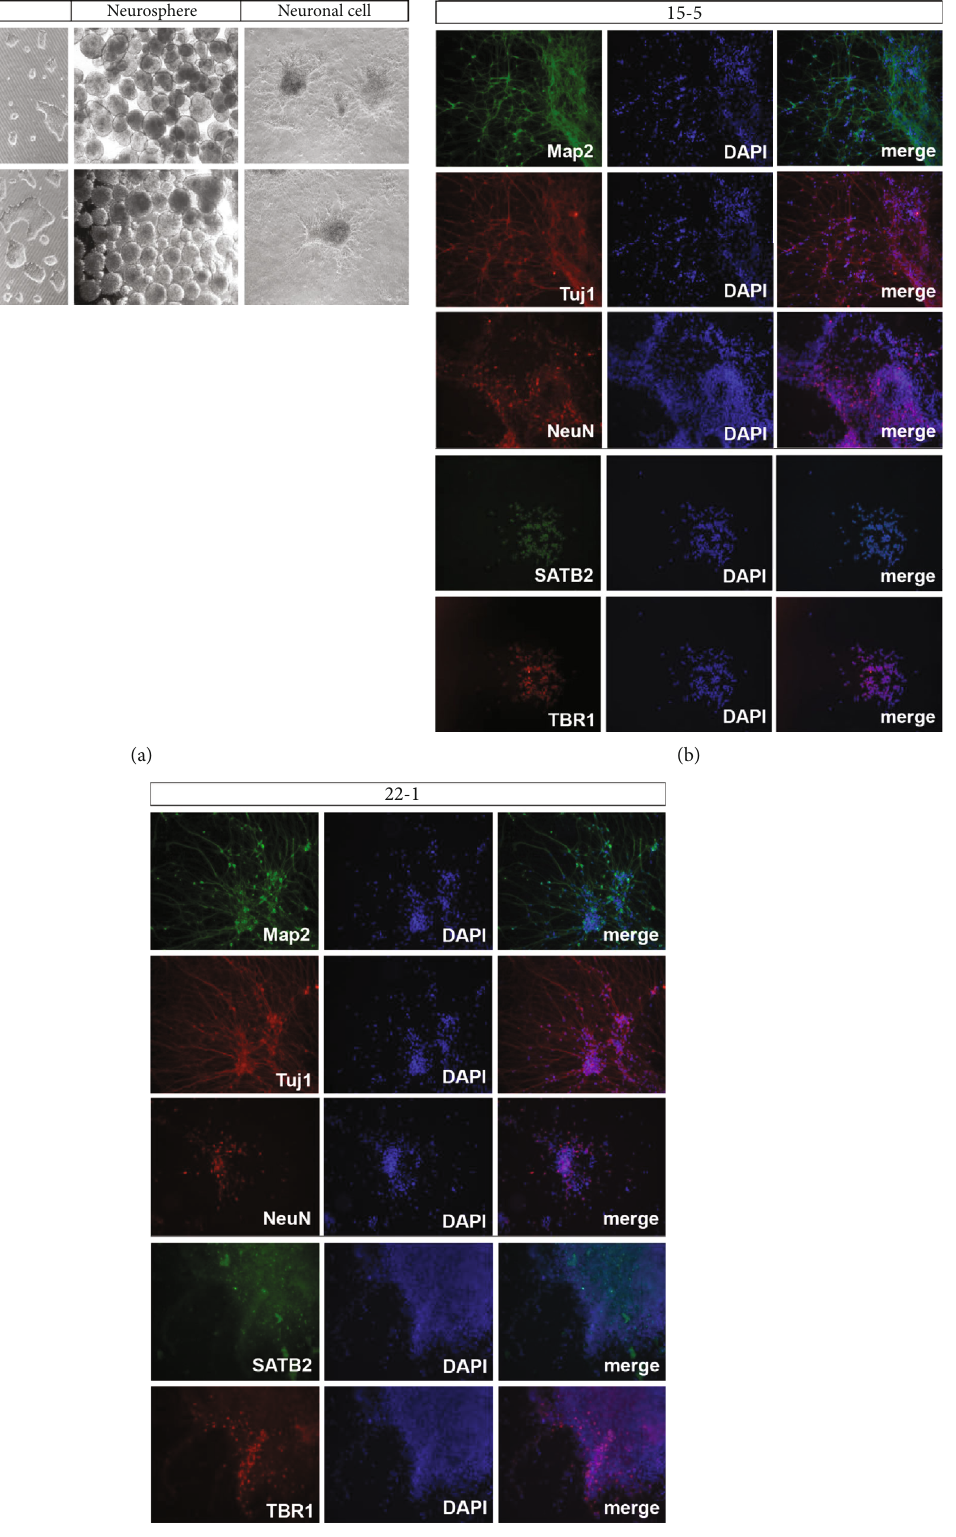
Figure 3: The result of di ff erentiation. A large number of neurospheres could be observed under the microscope (a). After 28 days of di ff erentiation and cultivation, the neuronal markers Tuj1, Map2, and NeuN and cortical neuronal markers SATB2 and TBR1 were detected by immuno fl uorescence, which showed that Tuj1, Map2, NeuN, SATB2, and TBR1 were positively expressed (b, c). n = 3